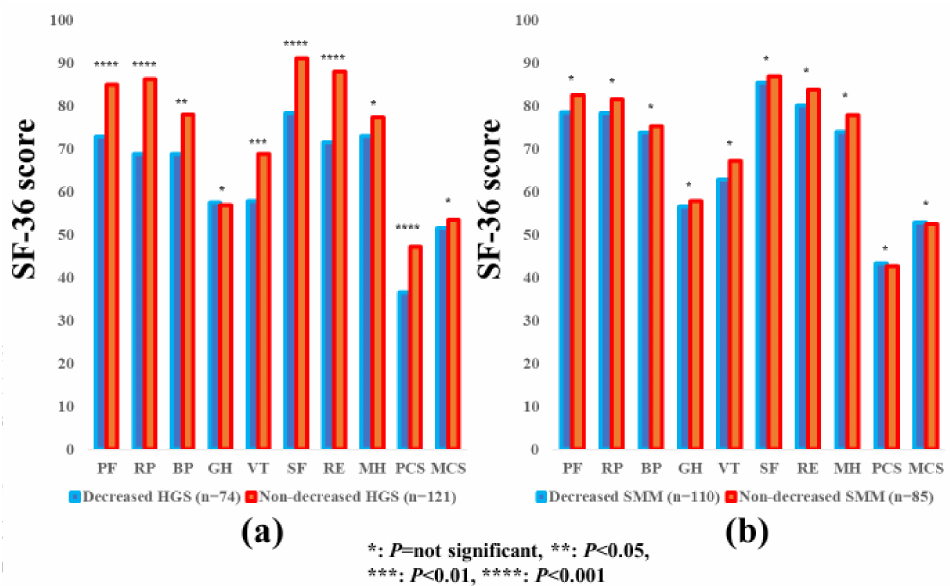
Figure 6. The SF-36 scores across 10 items in the decreased and non-decreased HGS groups ( a ), and the decreased and non-decreased SMM groups ( b ) in patients aged >65 years ( n = 195). The average scores in each item of the SF-36 were plotted.